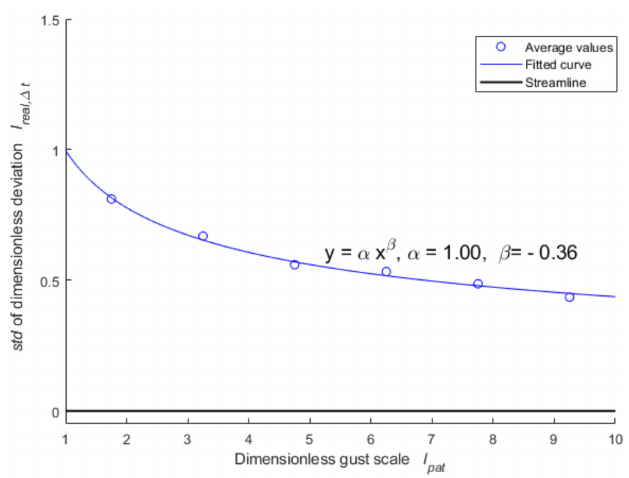
Figure 8. The relationship between dimensionless deviations and dimensionless gust scales. Circles are the average dimensionless deviations at different average gust scales, and the solid line is the fitting curve.